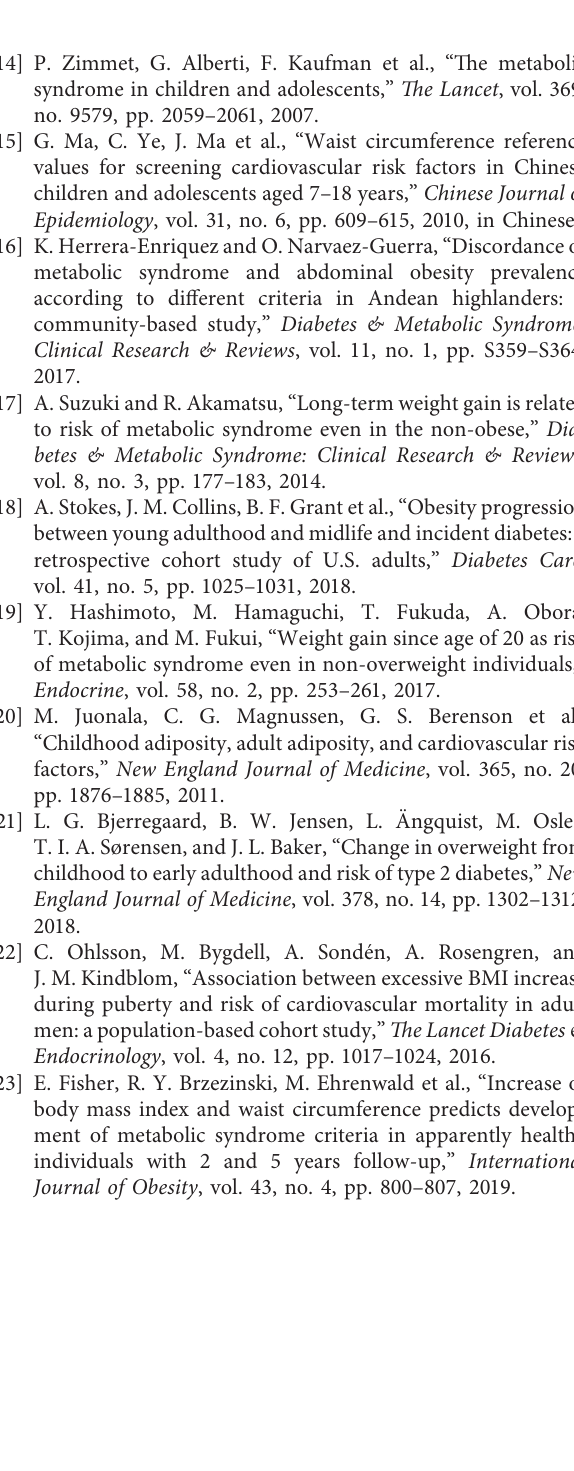
Supplemental Table 1: comparison of clinical characteristics between the follow-up subjects and the non-follow-up subjects. ( Supplementary Materials